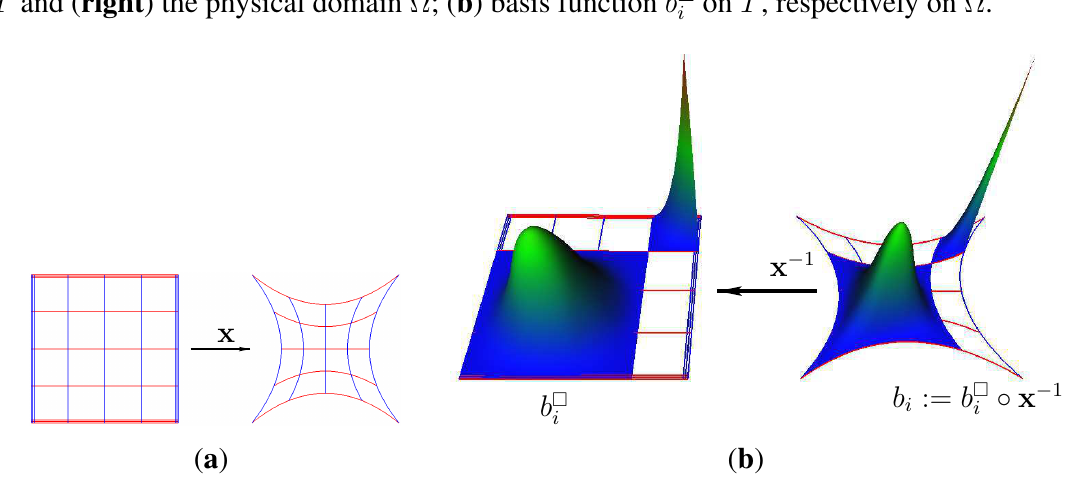
Figure 5. The non-smooth C 0 bi-3 basis function: ( a , left ) A quad mesh of points associated with B-spline-like functions, for n = 5 . ( a , right ) The coefficients of the patches